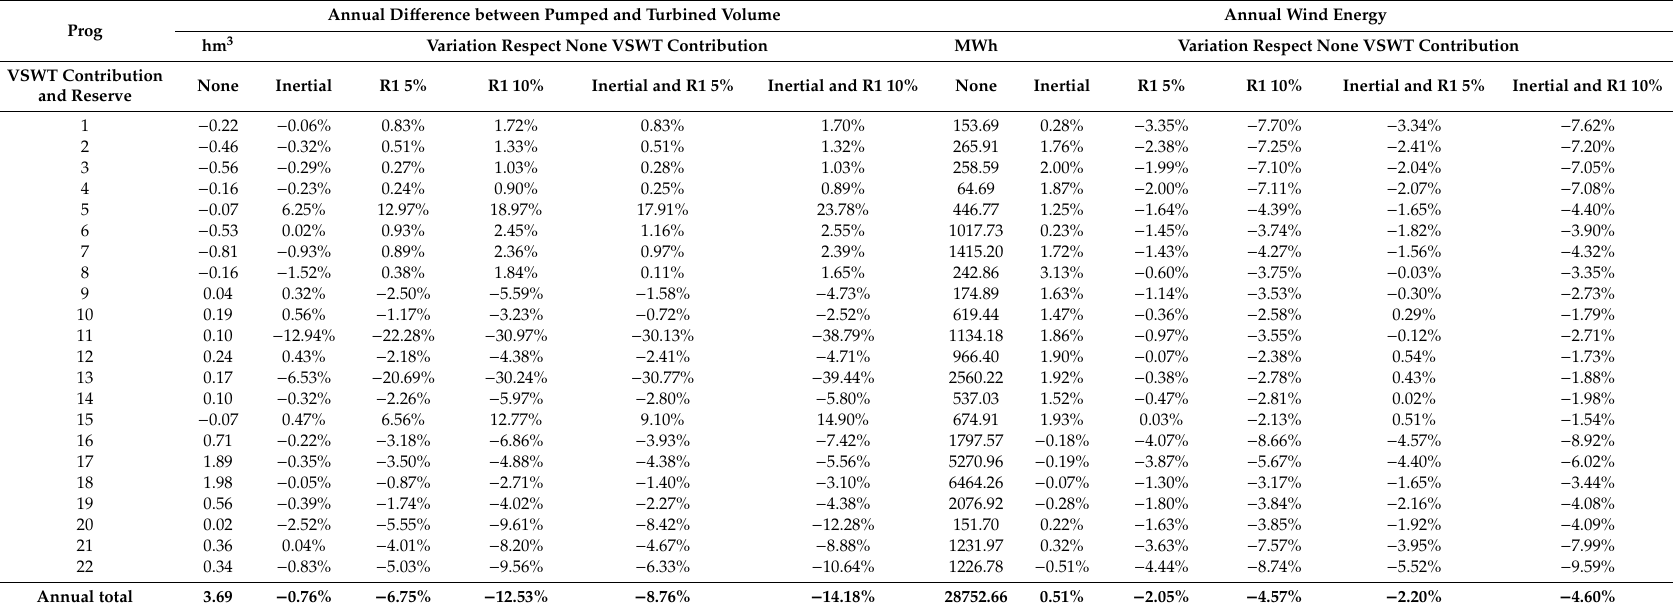
Table A3. Comparison of the hydraulic balance and wind energy produced between none VSWT contribution and the proposed VSWT contributions.